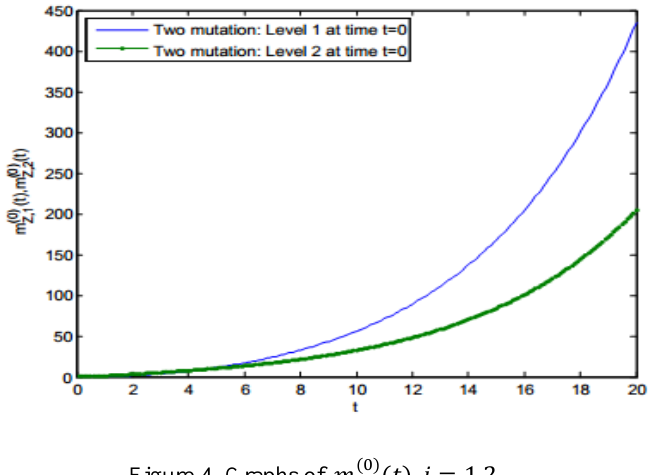
Figure 4. Graphs of 𝑚 𝑍,𝑗(0) (𝑡), 𝑗 = 1,2